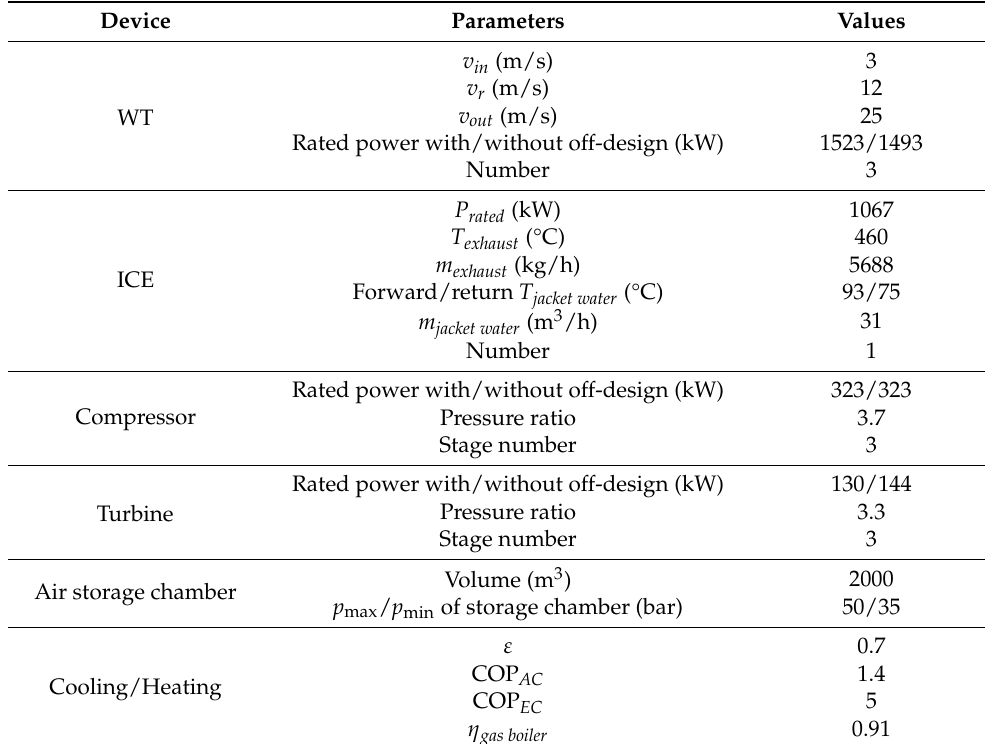
Table 4. Performance parameters of